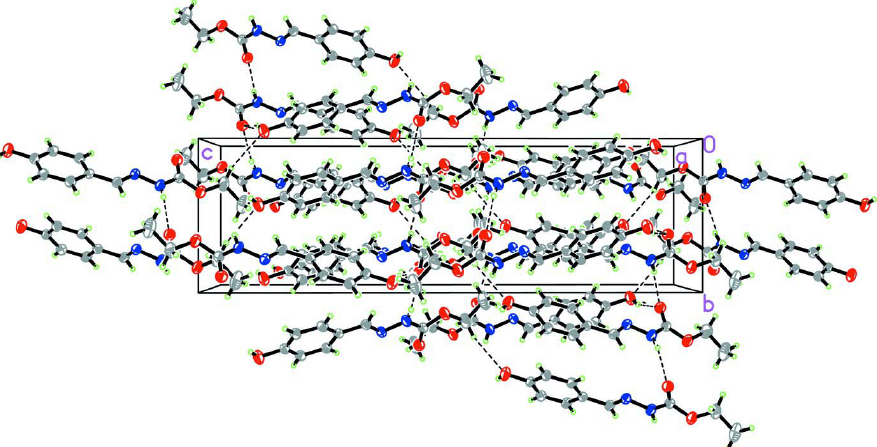
Figure 2 Crystal packing of the title compound, viewed approximately down the a axis. Dashed lines indicate intermolecular hydrogen